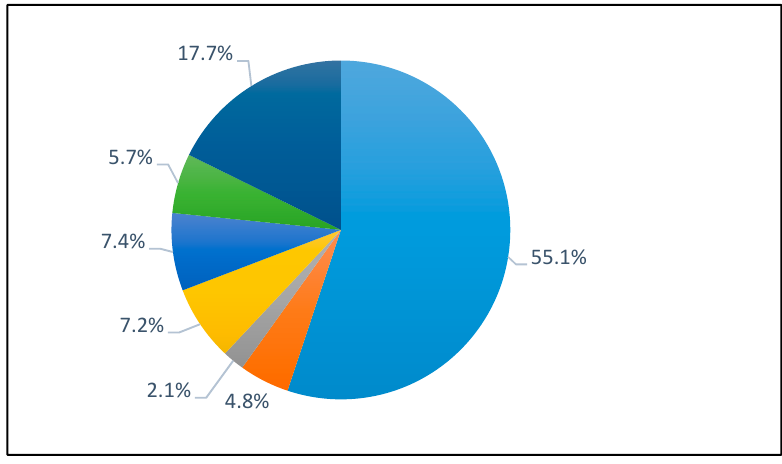
Figure 1. Fatty acids constitution of Schizochytrium sp. oil.